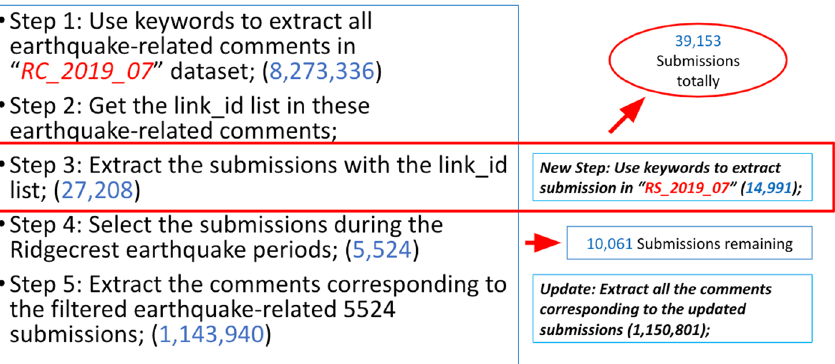
Figure 1. Filtering earthquake-related posts from the Reddit RC/RS